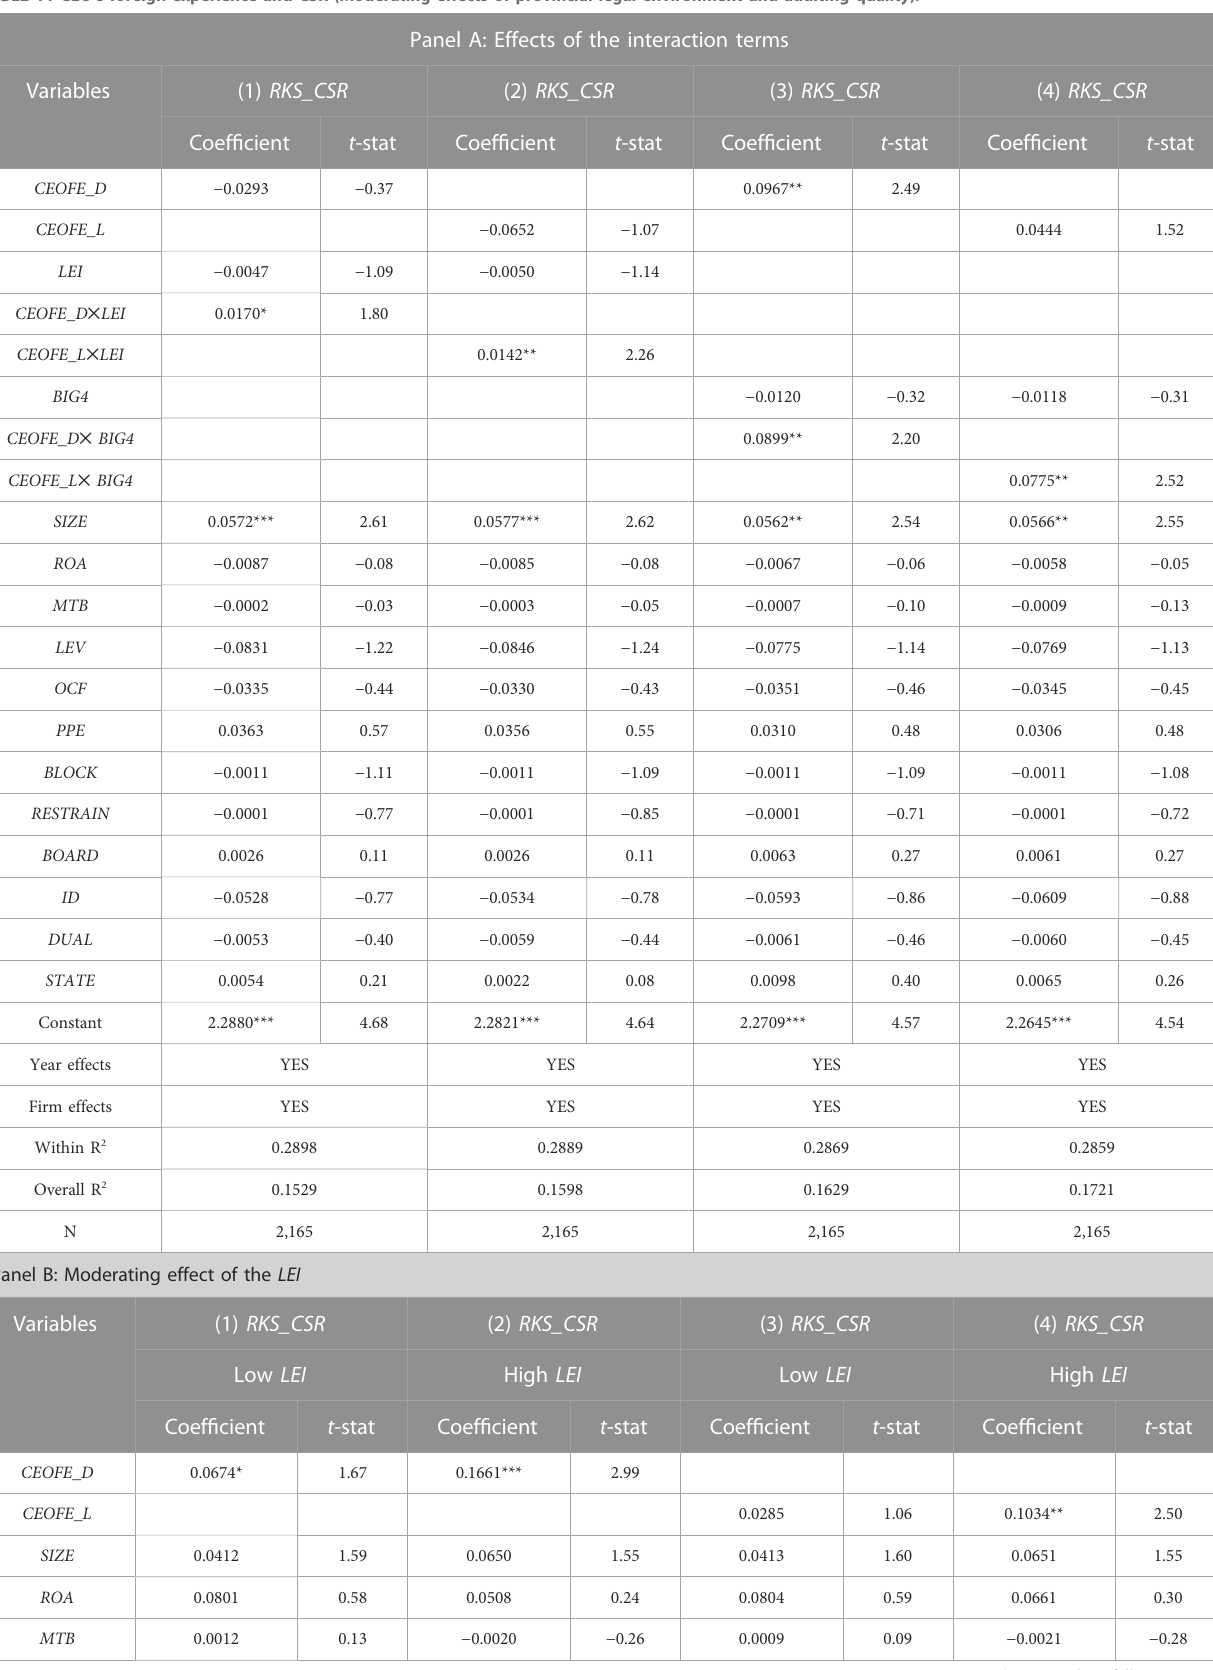
TABLE 11 CEO ’ s foreign experience and CSR (Moderating effects of provincial legal environment and auditing quality). Panel A: Effects of the interaction